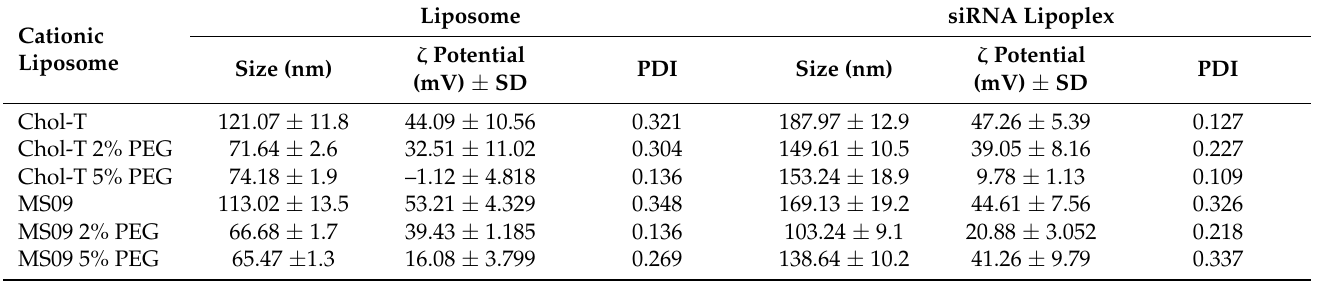
Table 4. Size, zeta ( ζ ) potential, and polydispersity indices (PDI) of the cationic liposomes and their complexes with siRNA at their optimum binding ratios ( w / w ).